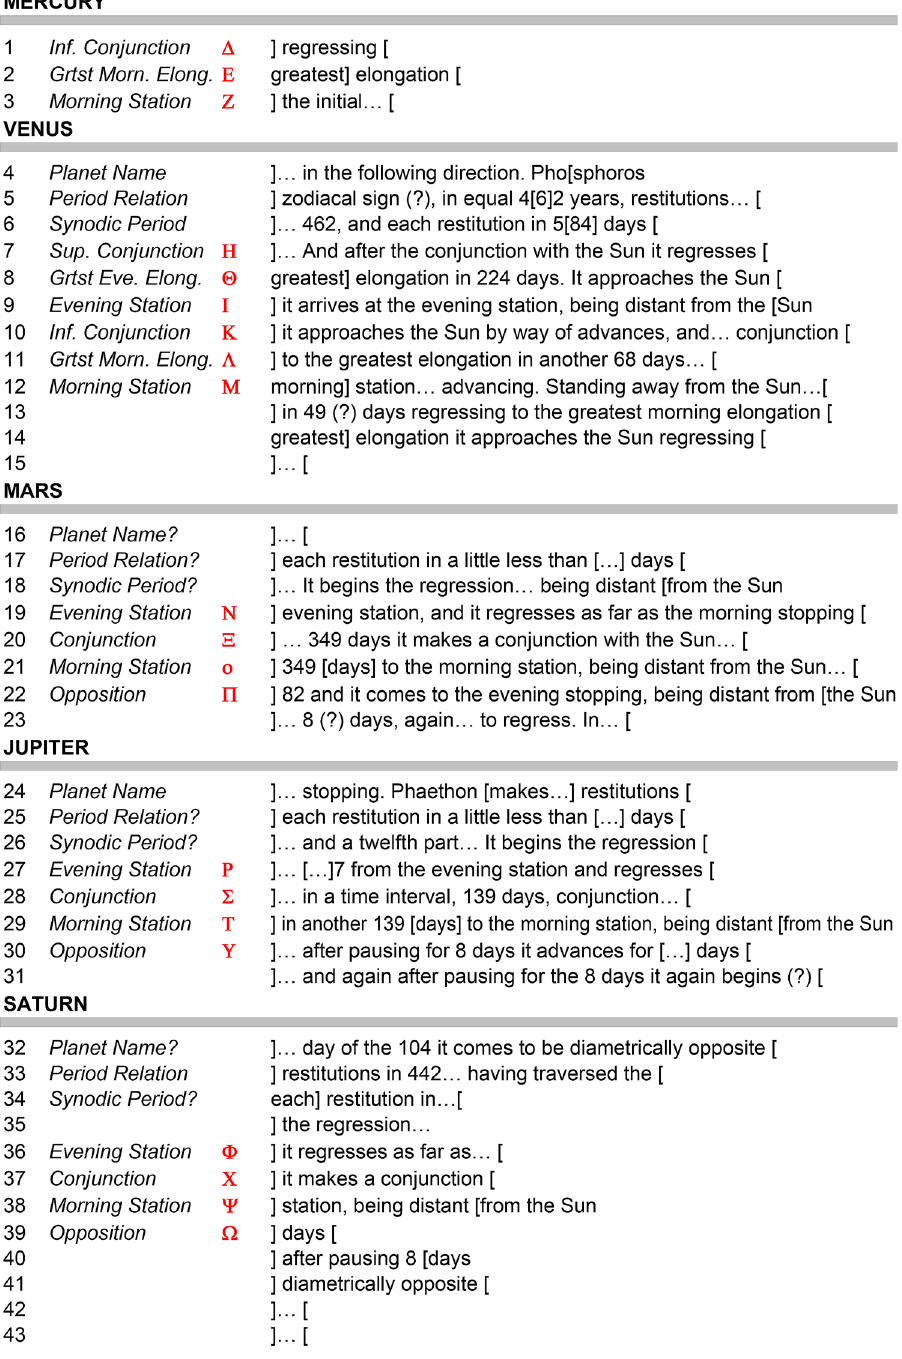
Figure 8. Hypothetical Index Letter Scheme for the FCI. The translation is from a previous publication 12 , where a transcription of the original Greek text can also be seen. The Index Letter scheme is in red. The whole scheme uses a single Greek alphabet from A to Ω , but the first few lines of Mercury are missing. The fragmentary data means that there are still many uncertainties in the lines of